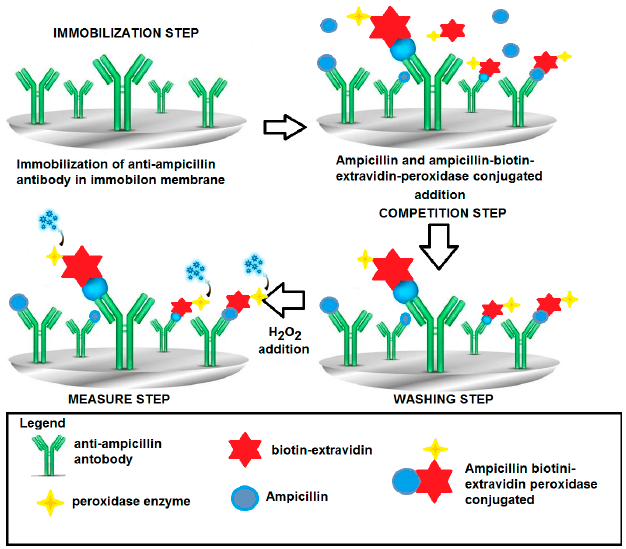
Figure 5. Scheme for determination of ampicillin by immunosensor using the “competitive format”; peroxidase enzyme as marker and H 2 O 2 electrode as transducer. Test geometry: Competition between ampicillin–biotin–avidin–peroxidase conjugated and ampicillin to be measured, both free in